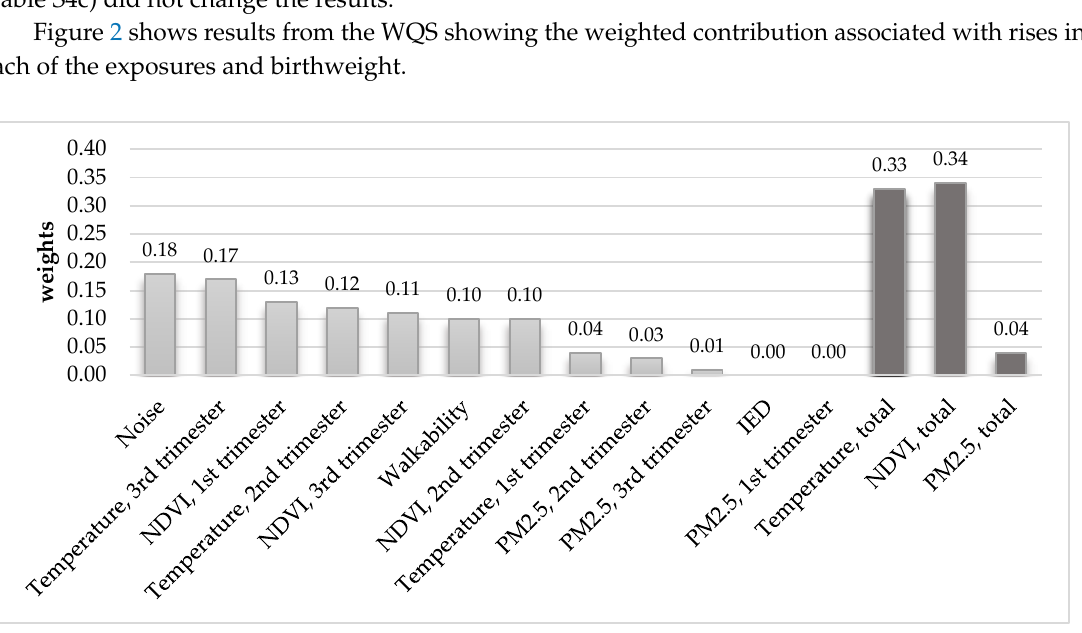
Figure 2. The weighted contribution of each of the selected exposures to a negative difference in birthweight: results of a Weighted Quantile Sum (WQS) regression.